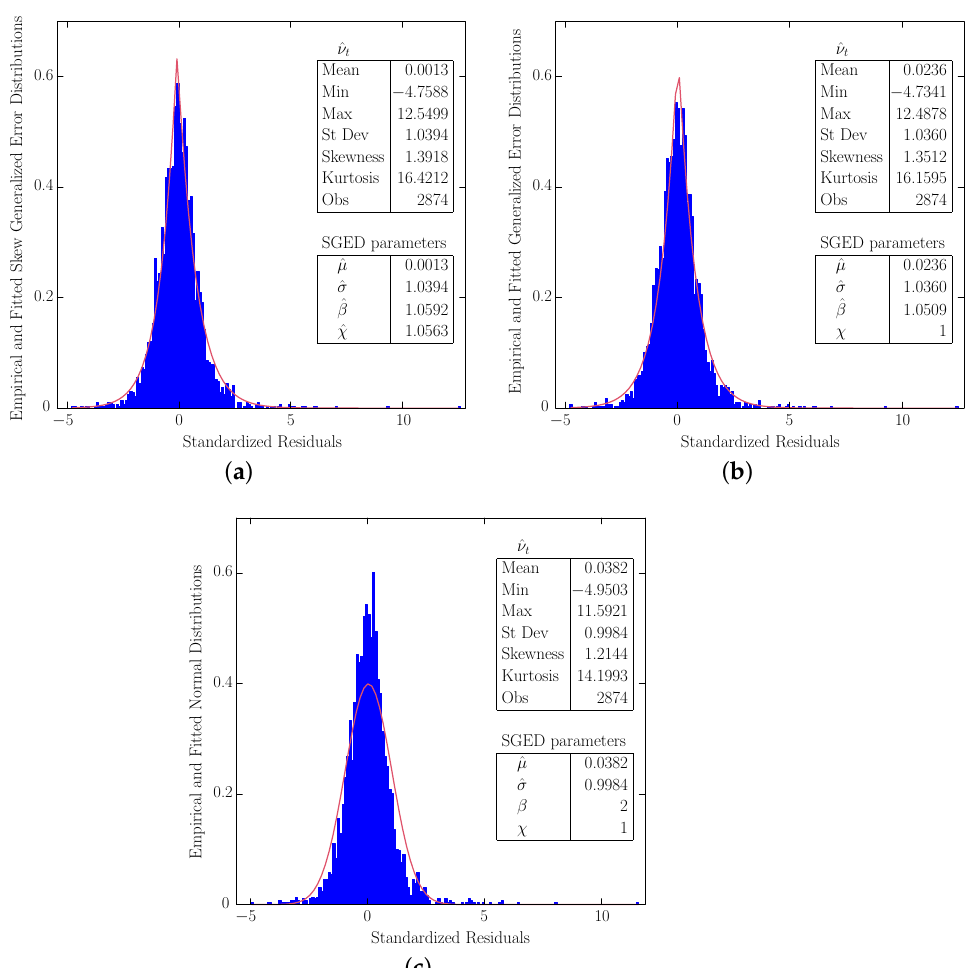
Figure 6. Empirical and fitted theoretical distributions of standardized residuals ˆ ν t . Notes: GED is a special case of SGED when χ = 1. Similarly, normal distribution is a special case of SGED when β = 2 and χ = 1. These details are summarized in Figure 3.